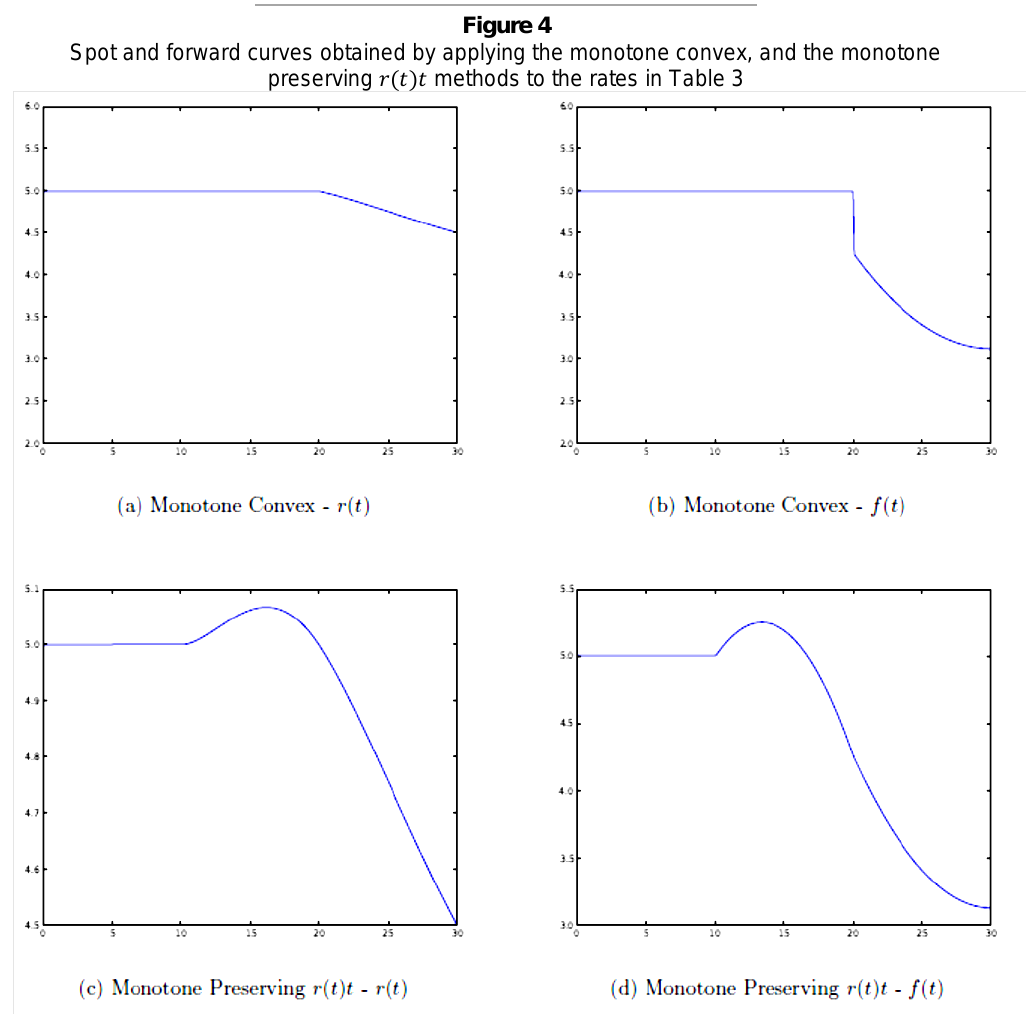
Spot and forward curves obtained by applying the monotone convex, and the monotone preserving methods to the rates in Table